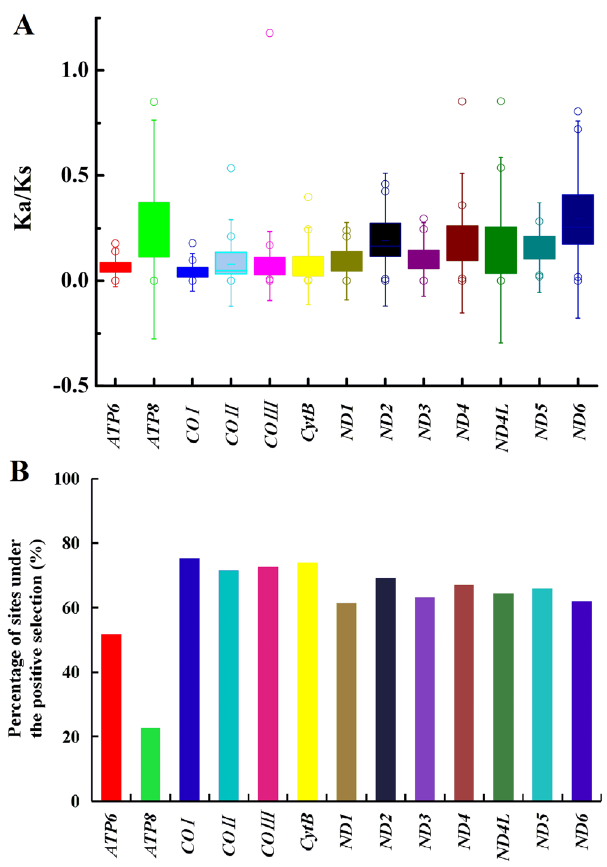
Figure 5. Positive selection estimated by FEL site-by-site analyses and pairwise divergence Ka/Ks ratio across mitochondrial protein-coding genes in 50 mosquito mitogenomes. ( A ) Ratios estimation. Box plot for pairwise divergence of Ka/Ks ratio for each one of the mitochondrial subunits. ( B ) Percentage of sites under positive